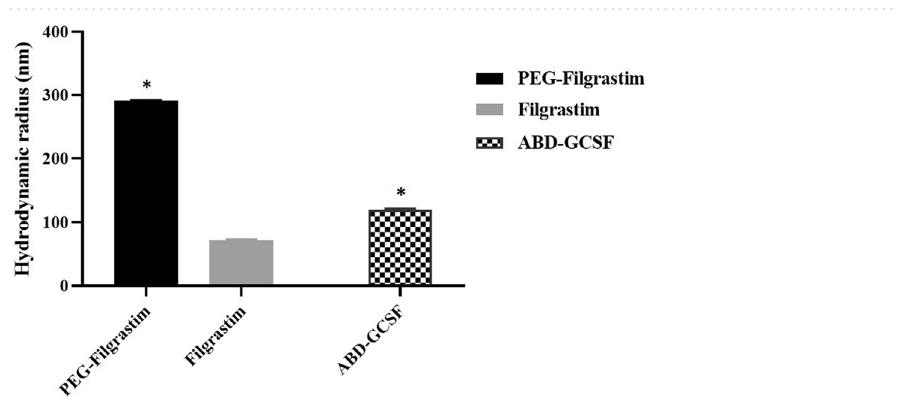
Figure 4. Dynamic light scattering measurements of ABD-GCSF and PEG-Filgrastim in comparison with Filgrastim. Data presented as mean ± SD. *Considered P values less than 0.05 in comparison to Filgrastim